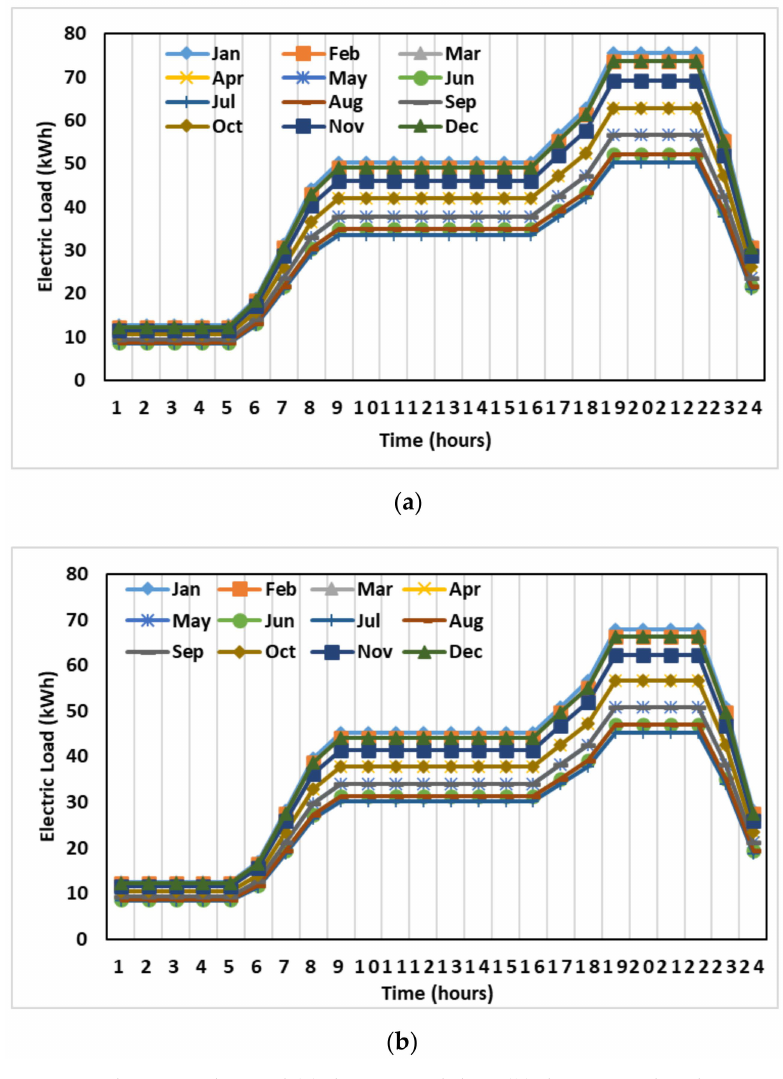
Figure 6. Electricity demand ( a ) during weekdays ( b ) during